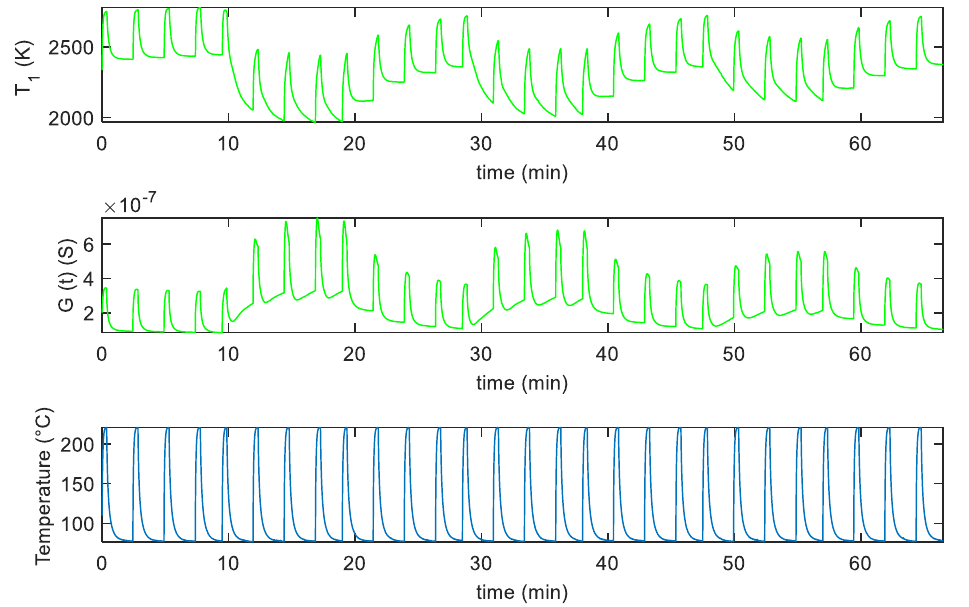
Figure 10. Measurement results for the G and T 1 as a function of time for the SWCNT-TiO 2 decorated sensor sample assuming the measurement profile as simulated in Figure 8 with an additional pure air phase preceding the NO 2 injection.